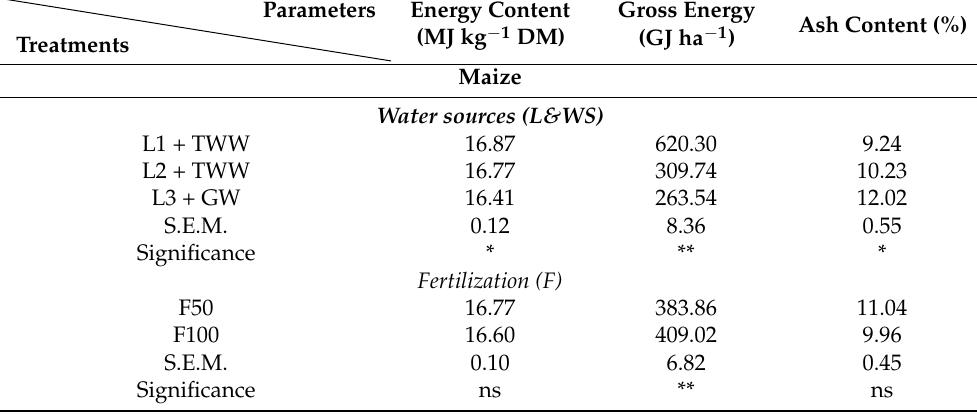
Table 6. Effects of individual factors of water resources and fertilization treatments on energy and ash traits of maize, sorghum, and pearl